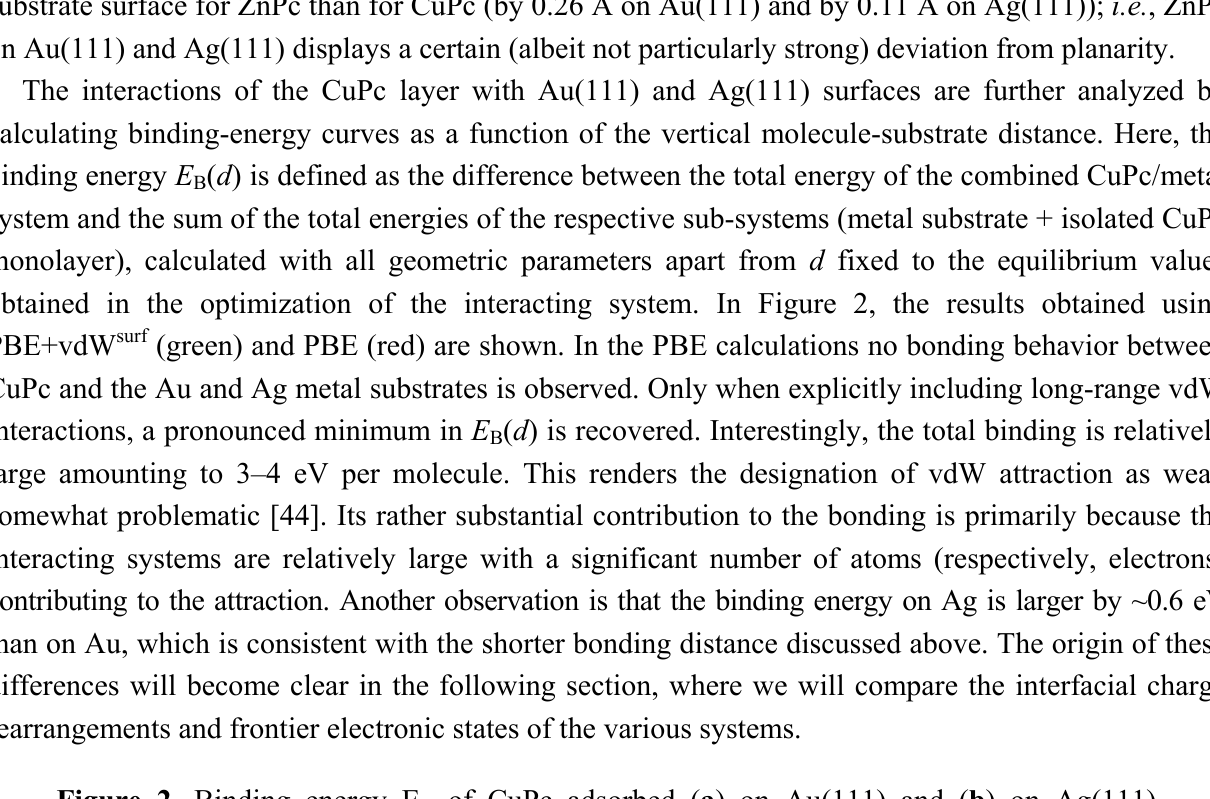
Figure 2. Binding energy E of CuPc adsorbed ( a ) on Au(111) and ( b ) on Ag(111) B surfaces, as a function of the vertical distance, d . For determining d , the vertical positions of the carbon atoms in the CuPc molecules and the metal atoms in the relaxed top metal layer are